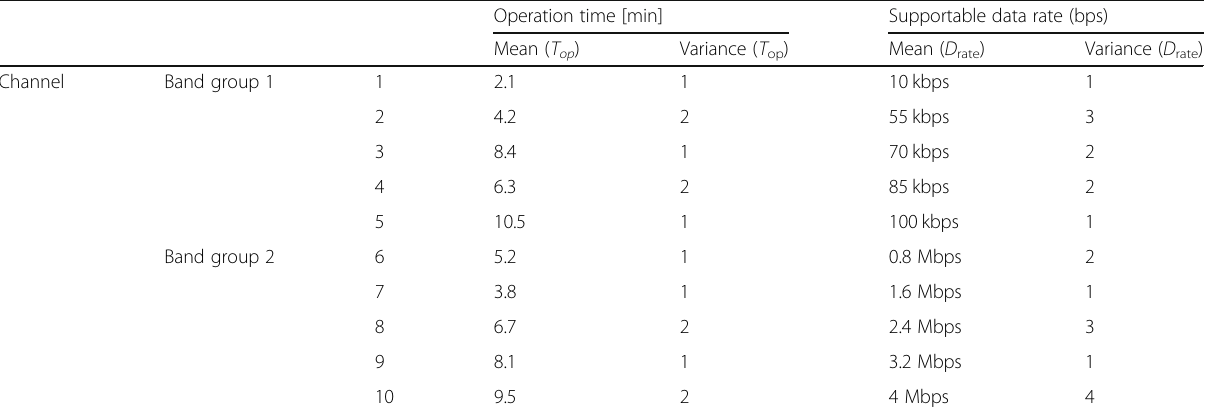
Table 1 Channel parameters for band groups 1 and 2